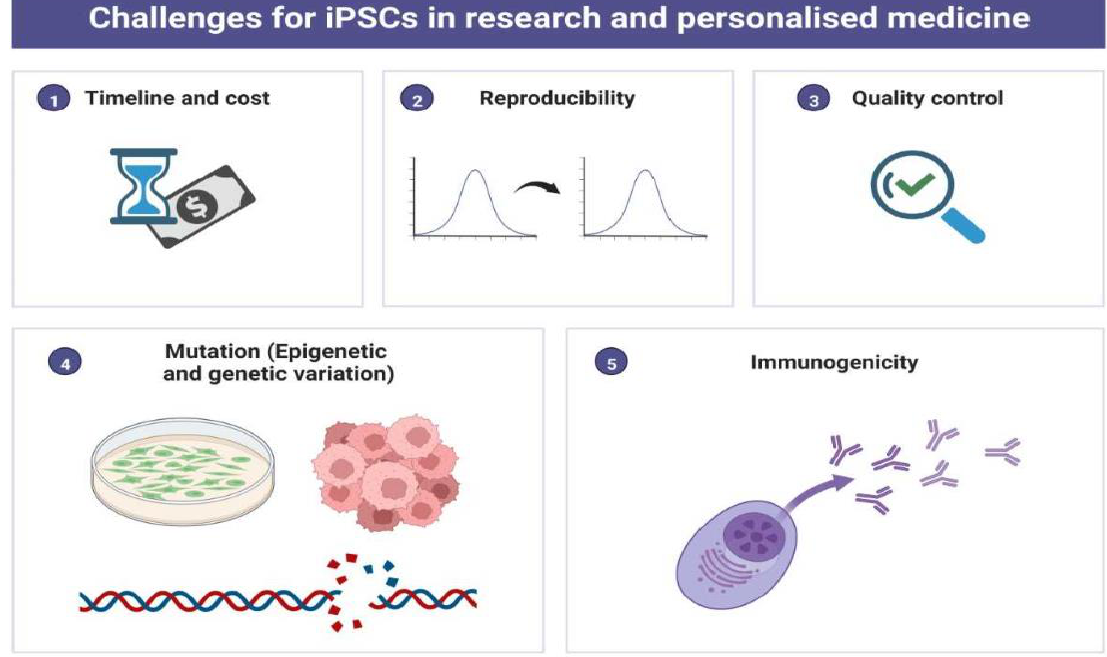
Figure 5. Pictorial Diagram Representing Challenges for iPSCs in Scientific Research and Personalized Medicine. The figure has been created with BioRender.com, accessed on 2 September 2022.